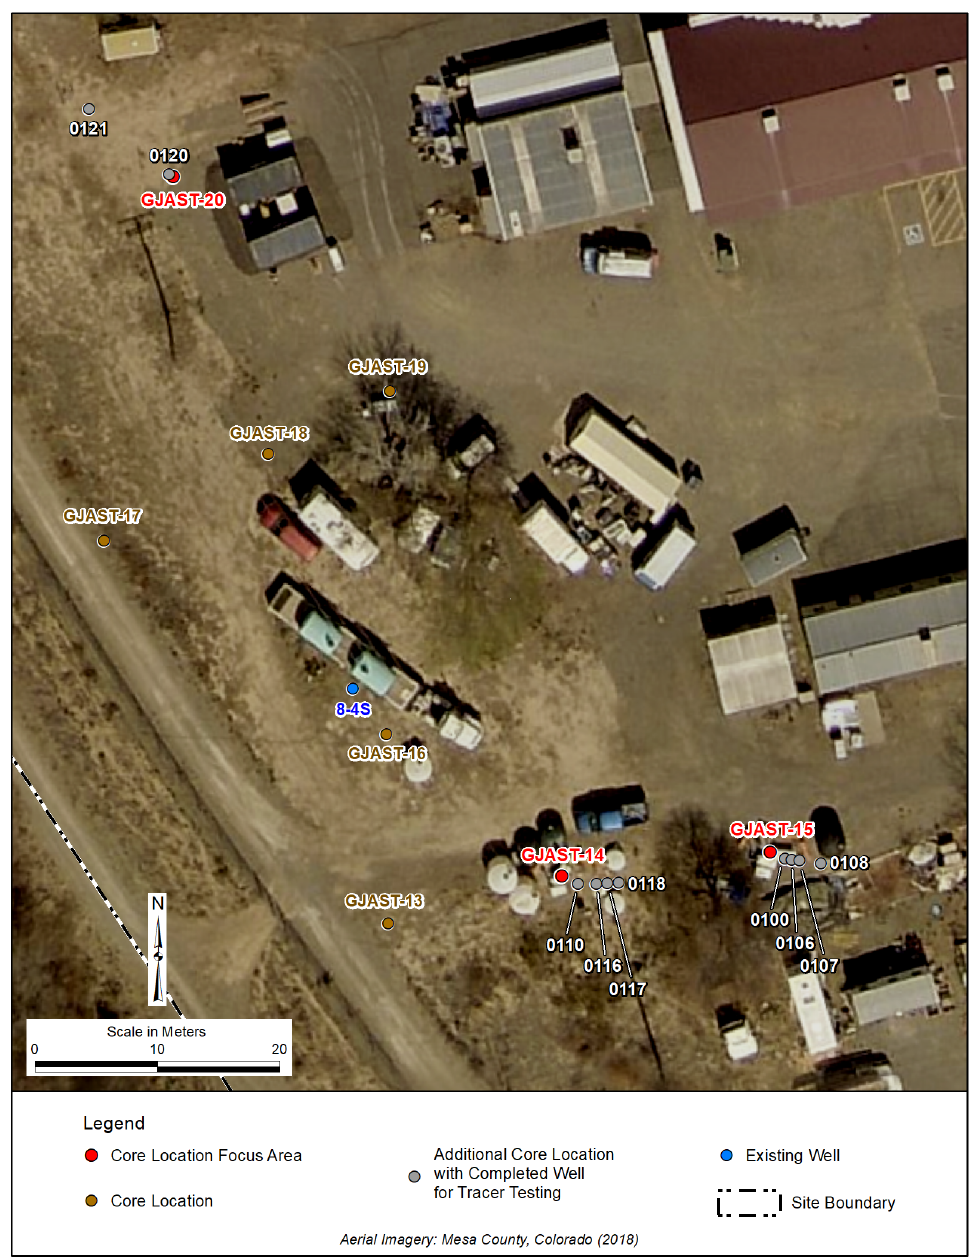
Figure 3. Zoomed-in image from Figure 1 around well 8-4S showing additional coring locations that were used for sediment compositing. Wells were completed in these coring locations for subsequent tracer testing.